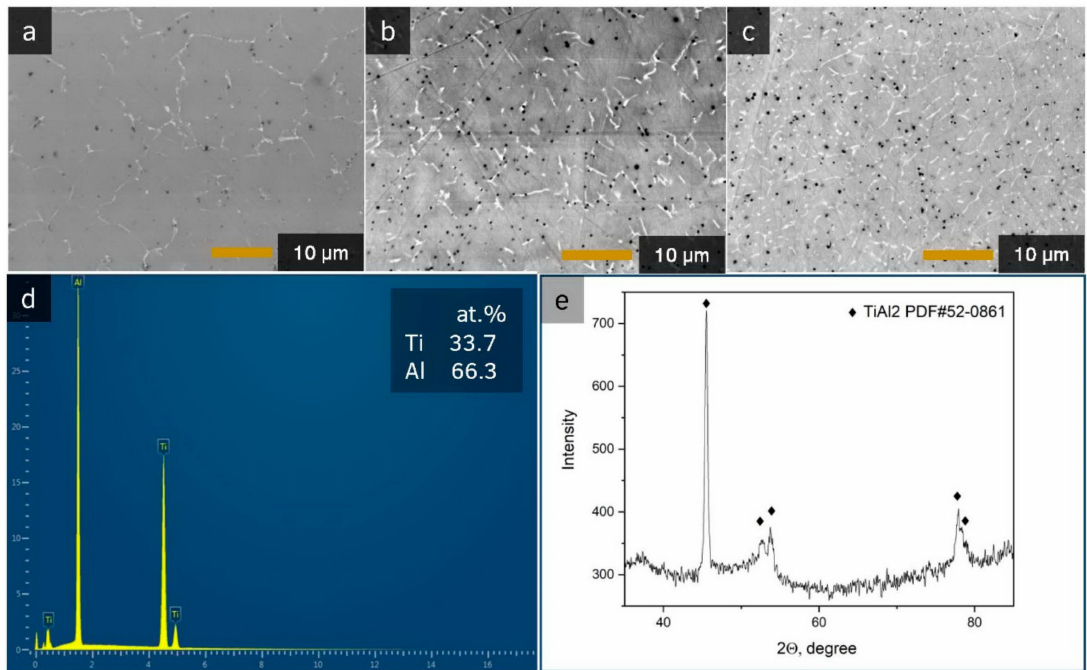
Figure 3. TiAl-based material prepared by selective laser printing at scan rates v = 50 ( a ), 75 ( b ), and 100 mm / s ( c ); ( d ) shows typical elemental composition of printed materials. TiAl 2 grains are shown in grey, Ti 3 Al inclusions in bright grey, and pores in black; ( e ) corresponding XRD